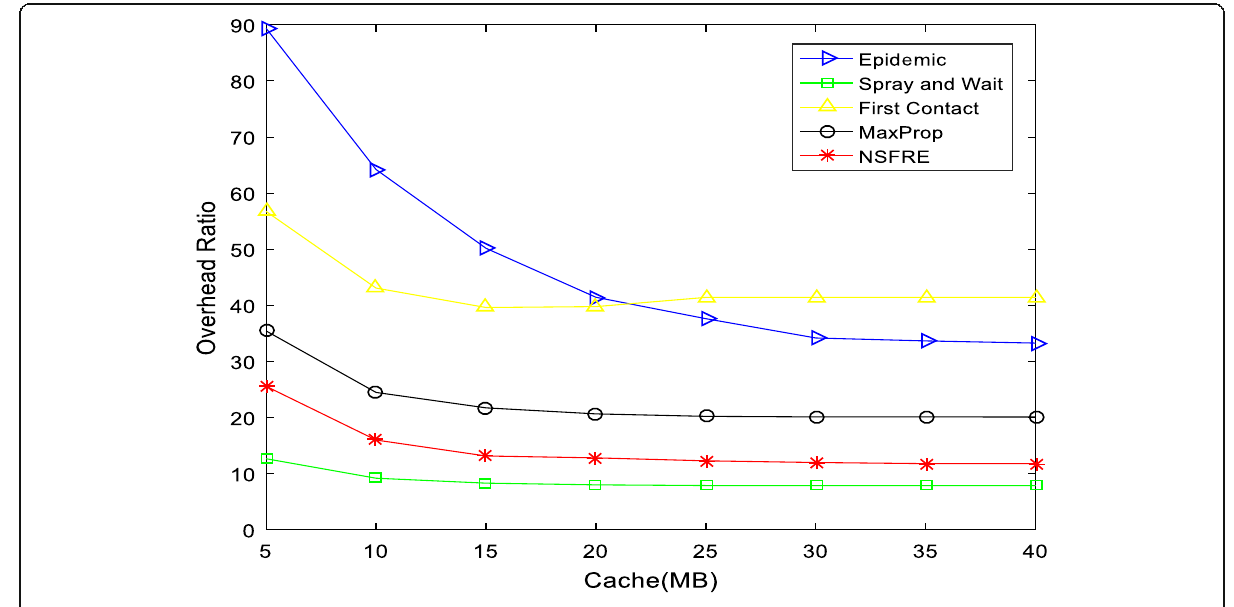
Fig. 11 The relationship between routing overhead and node